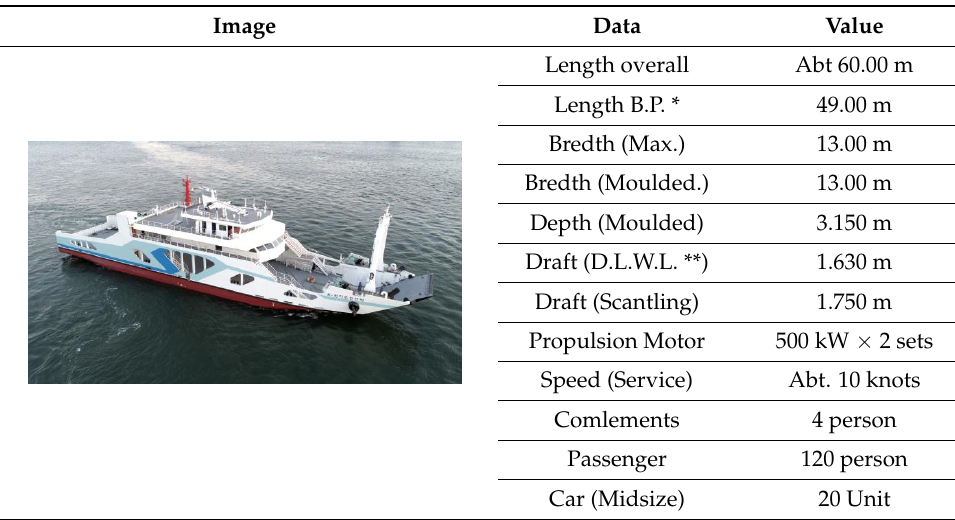
Table 3. Specifications of target small car ferry subject to the BSS installation.